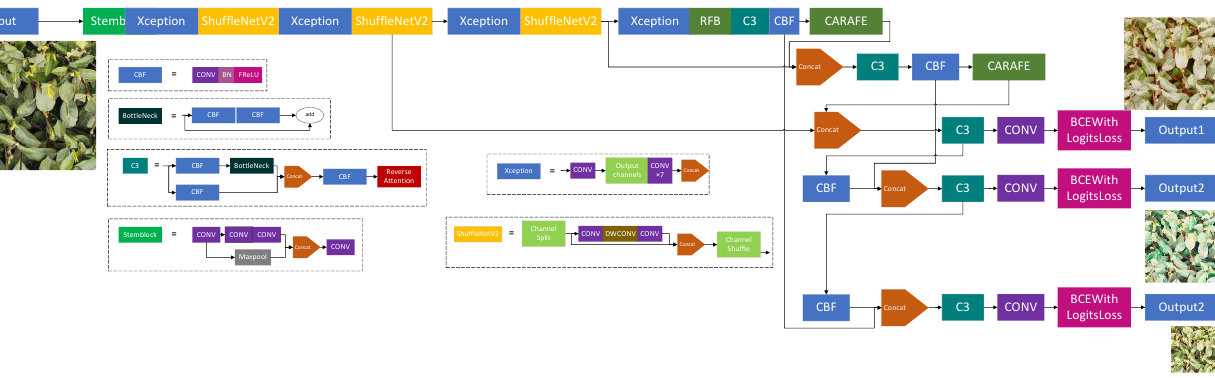
Figure 11. Improved YOLOv5 network structure. Table 3. Training platform